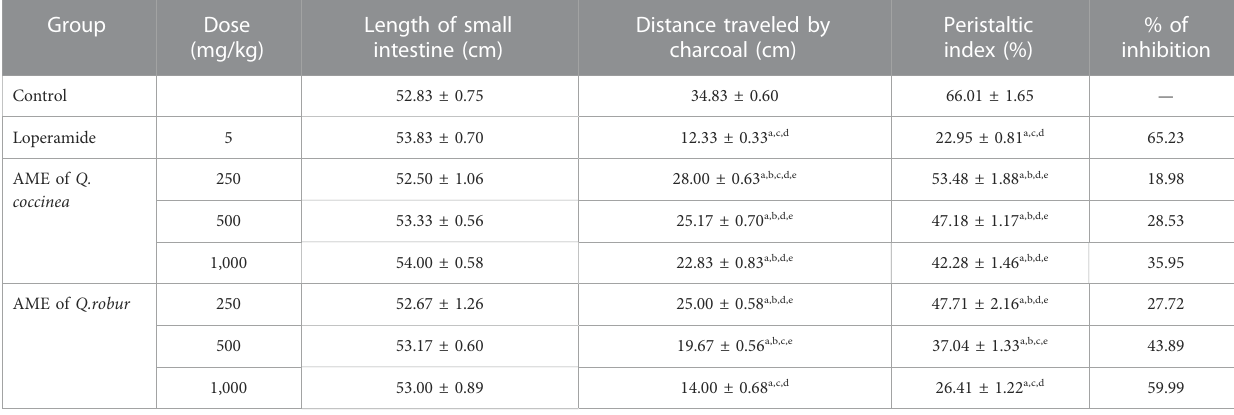
Distance traveled by charcoal